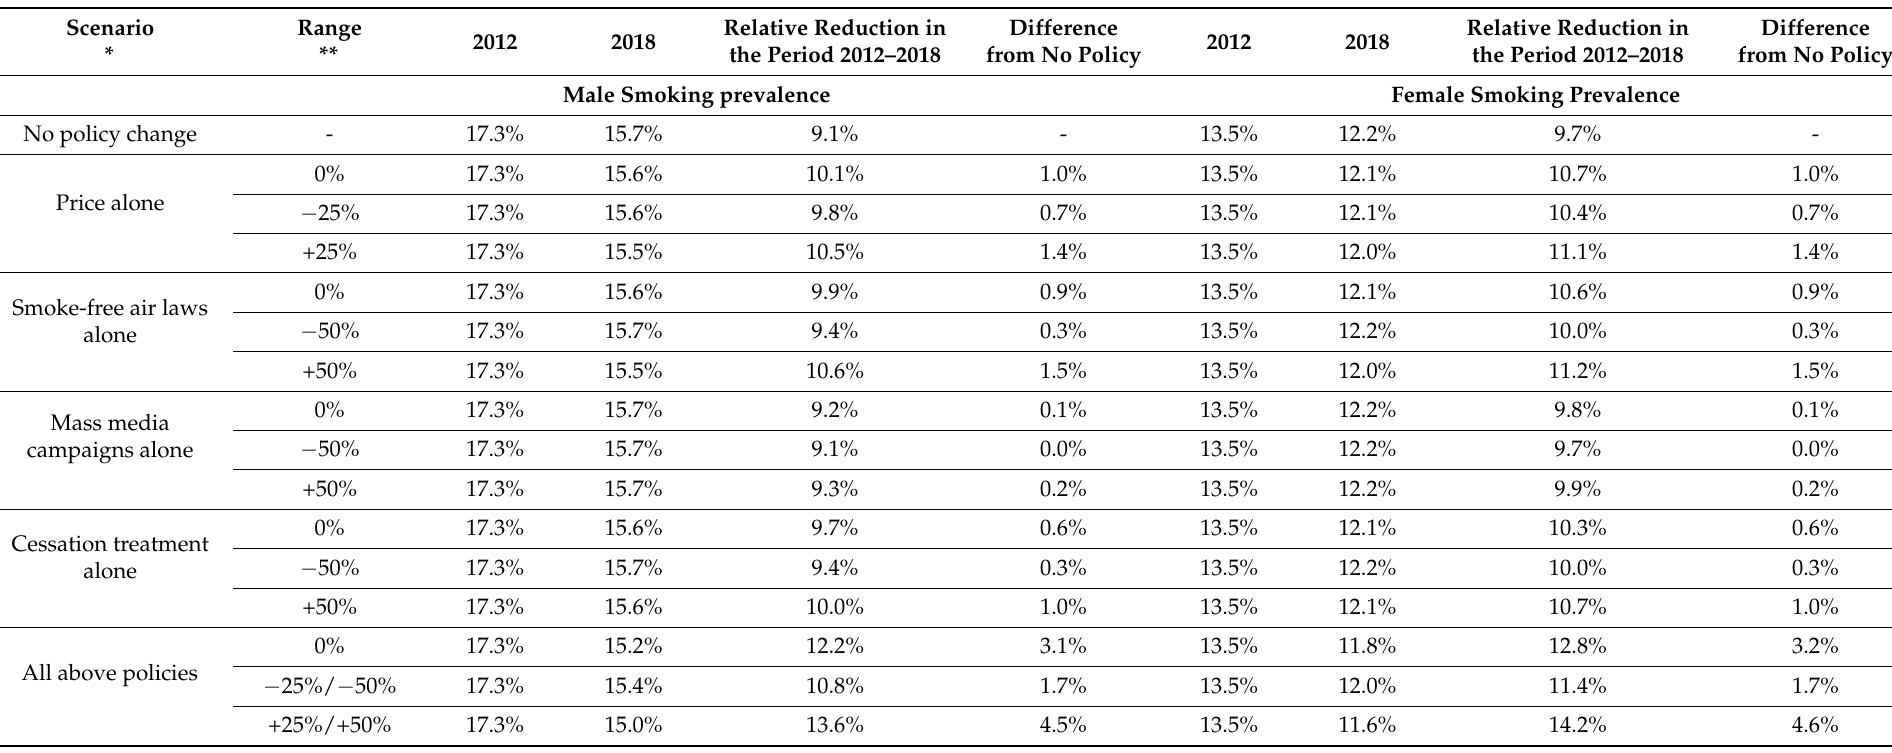
Table 4. Marginal sensitivity analysis of smoking prevalence to the policy changes in the period 2012–2018 as a result of their effect sizes, ages 18 and